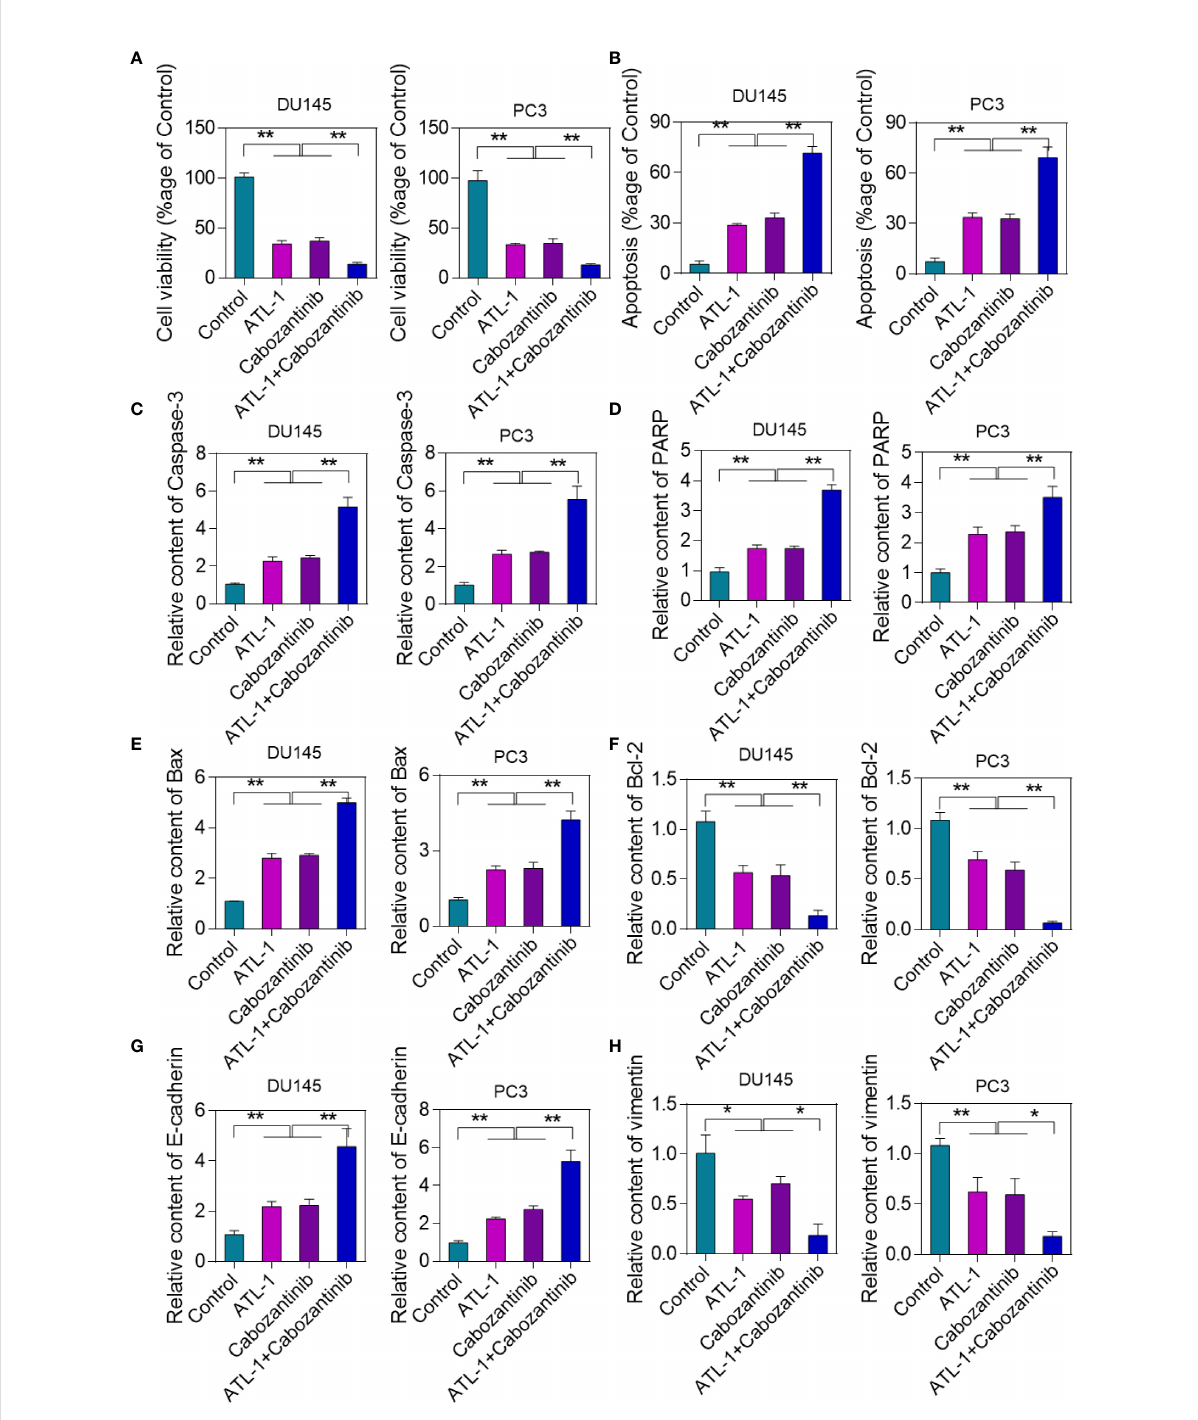
FIGURE 5 ATL-1 inhibition of Hsp27 enhances the antitumor effect of cabozantinib. (A) MTT assay to analyze cell viability in different treatment groups. The drug concentration of ATL-1 used was 10 m M. (B) TUNEL assay to detect cell apoptosis. Results are expressed as a percentage. (C) qRT-PCR analysis of the expression level of apoptosis-related gene caspase-3. (D) qRT-PCR analysis of the expression level of apoptosis-related gene PARP. (E) qRT-PCR analysis of the expression level of apoptosis-related gene Bax. (F) qRT-PCR analysis of the expression level of apoptosis- related gene Bcl-2. *p < 0.05, **p < 0.01 by one-way ANOVA analysis. (G) qRT-PCR analysis of the expression level of E-cadherin. (H) qRT-PCR analysis of the expression level of